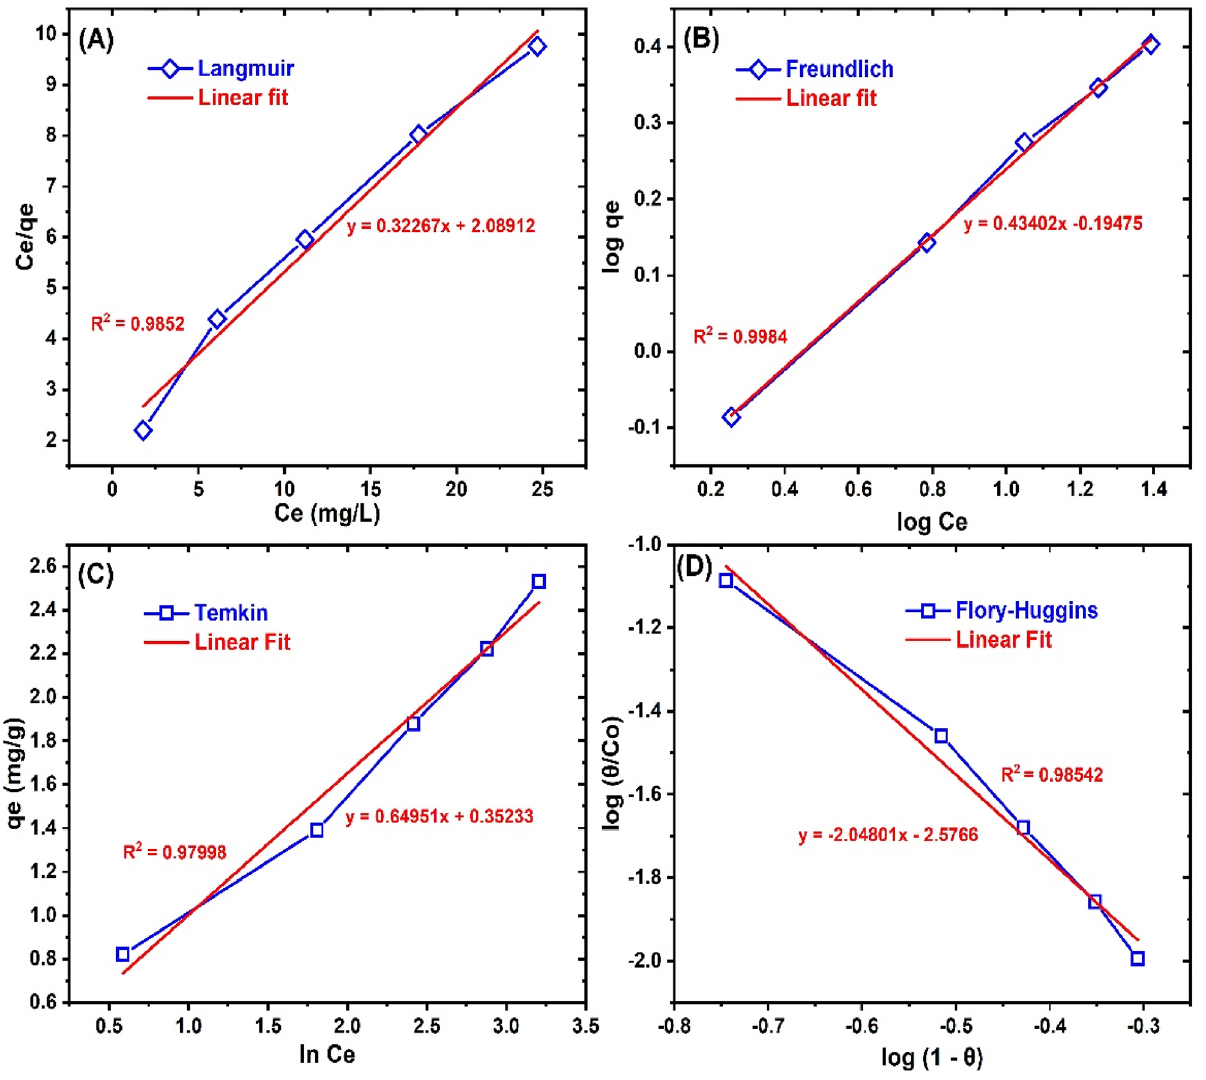
Figure 4. The ( A ) Langmuir ( B ) Freundlich ( C ) Temkin and ( D ) Flory–Huggins isotherm plots for the adsorption of BRP onto